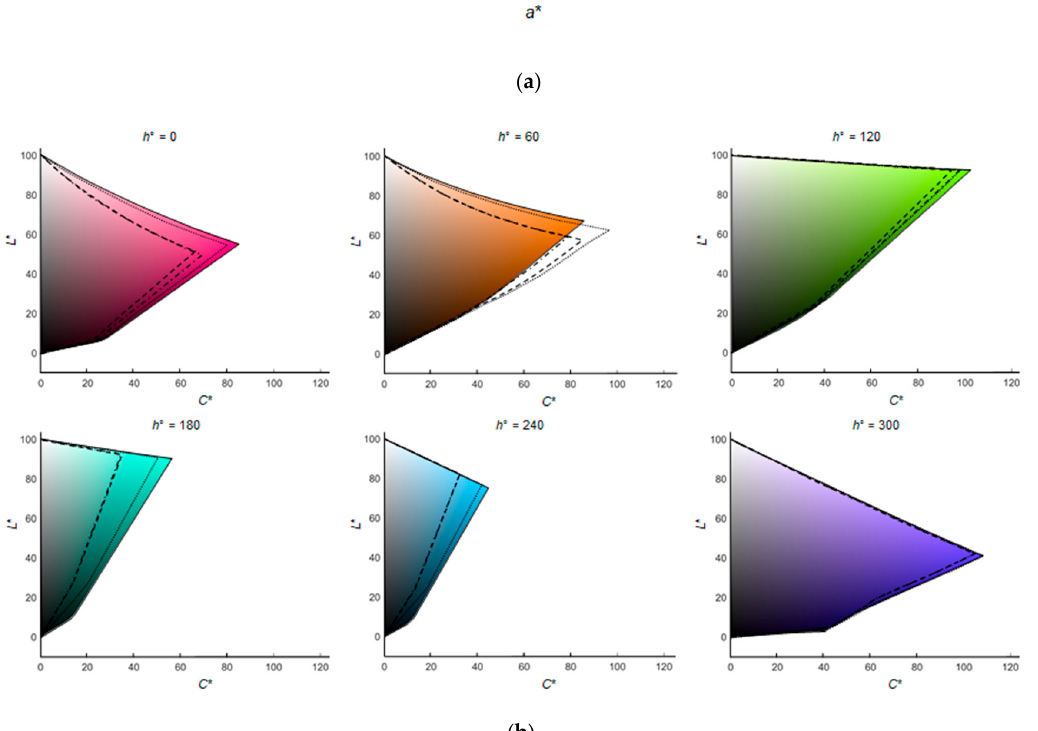
Figure 7. ( a ) CIELAB projection of the full 3-D gamuts (sRGB — , dipic ····· , L c2 – – – , do3a – · – · ) onto the a * b * plane for the three series of Ln complexes with primaries combining to a D65 white point, and ( b ) corresponding hue cuts in CIELCh (cylindrical representation of CIELAB).